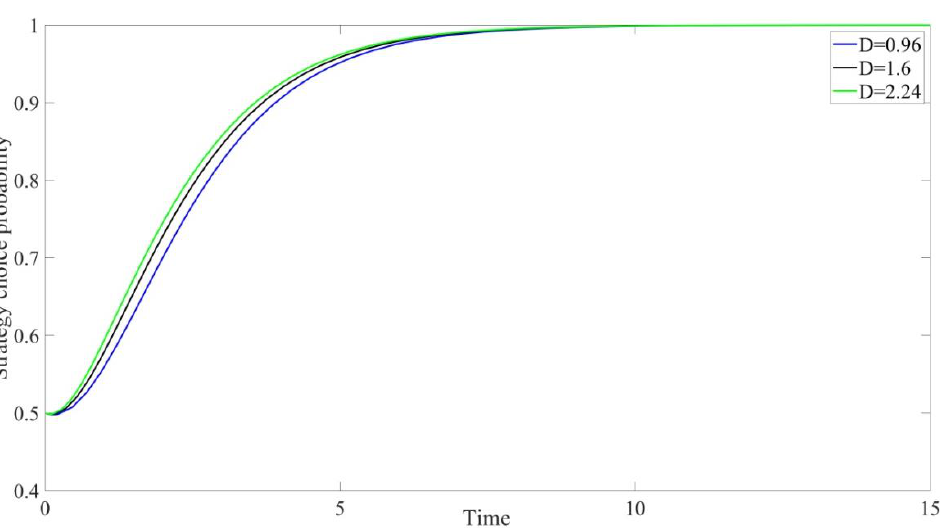
Figure 13. Simulation of different efforts to introduce and cultivate cross-border e-commerce tal- ent.